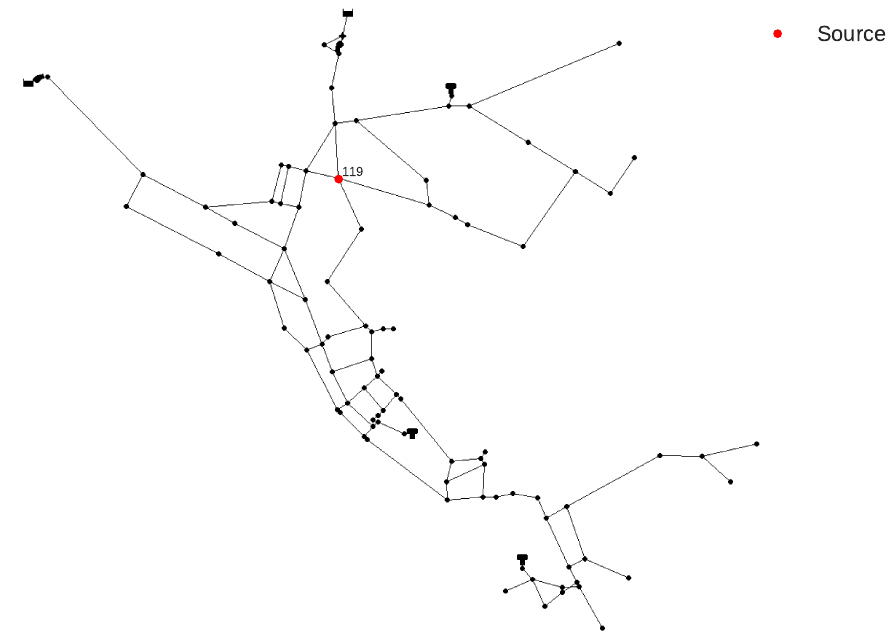
Figure 6. Net3 water supply network contamination source